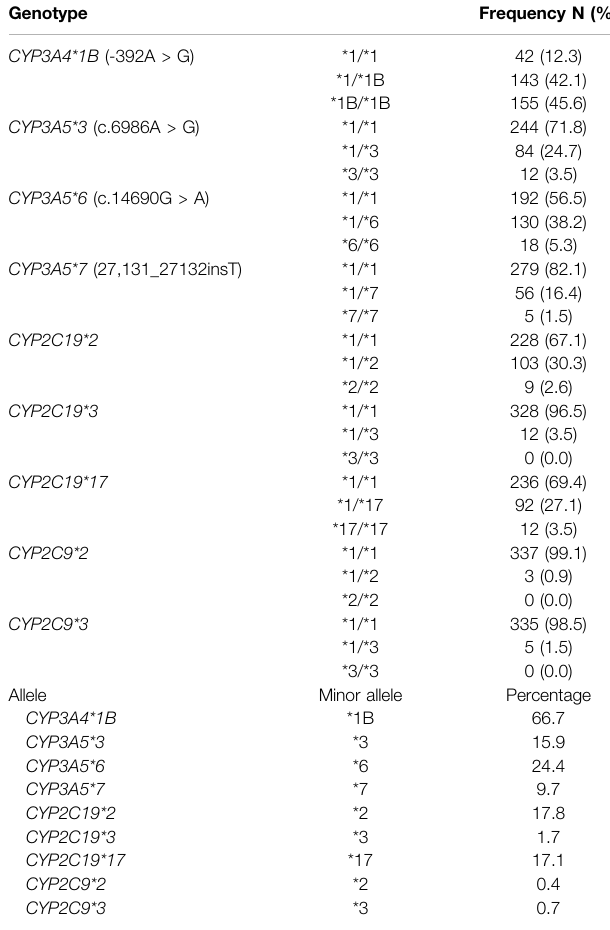
TABLE 2 | Genotypes and allele frequencies for CYP3A4 , CYP3A5 , CYP2C9 and CYP2C19 in the study